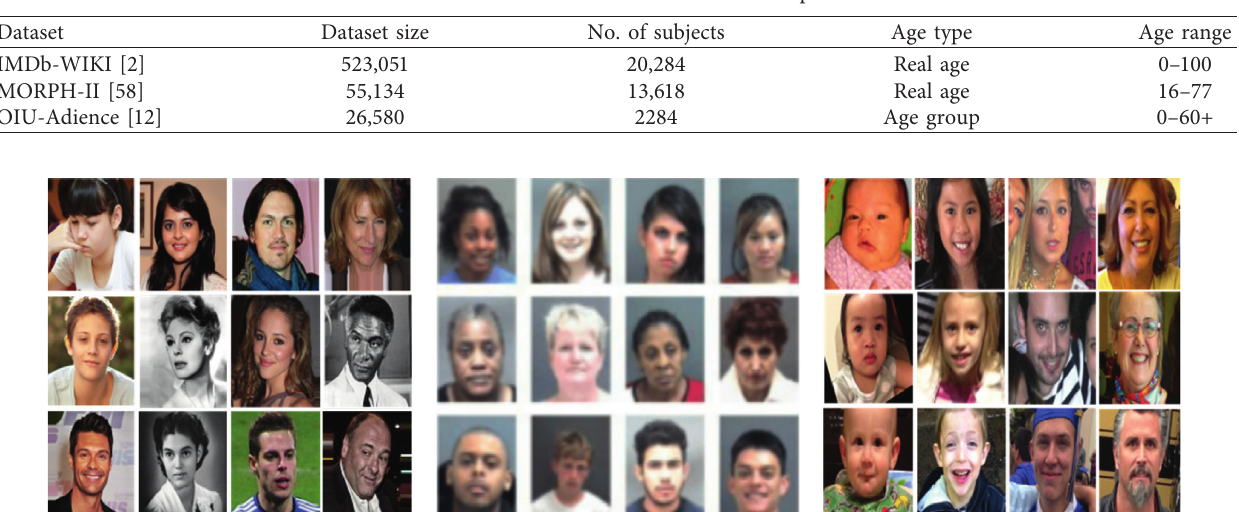
Table 3: The details of the datasets used in our experiments.